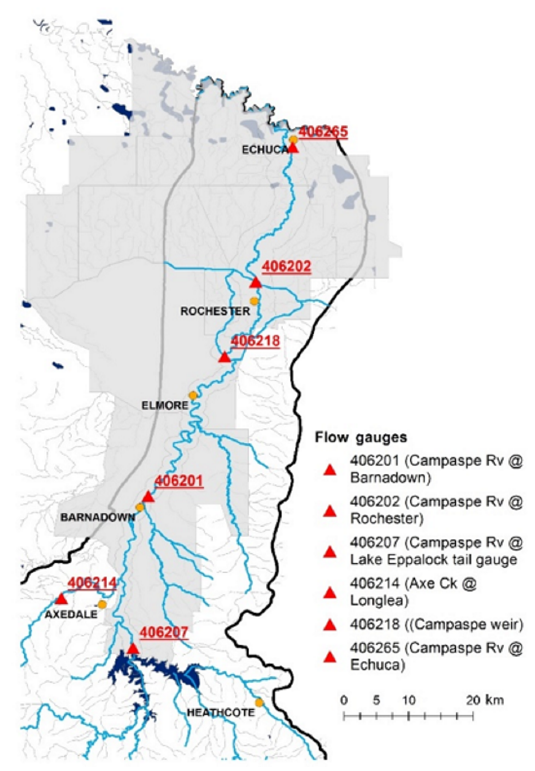
Figure 6. Flow gauges in the lower